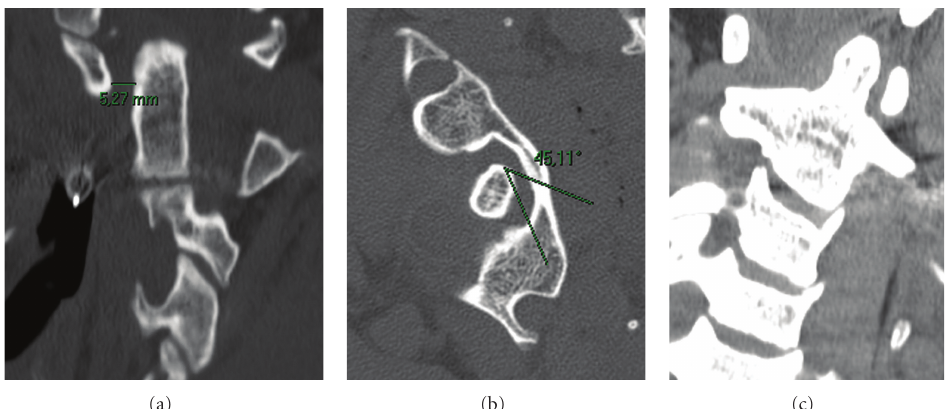
Figure 1: Computed tomography scans showing an atlanto-dental interval greater than 5 mm (a), 45 degrees of rotation (b), and asymmetry of the lateral masses of C1 (c).